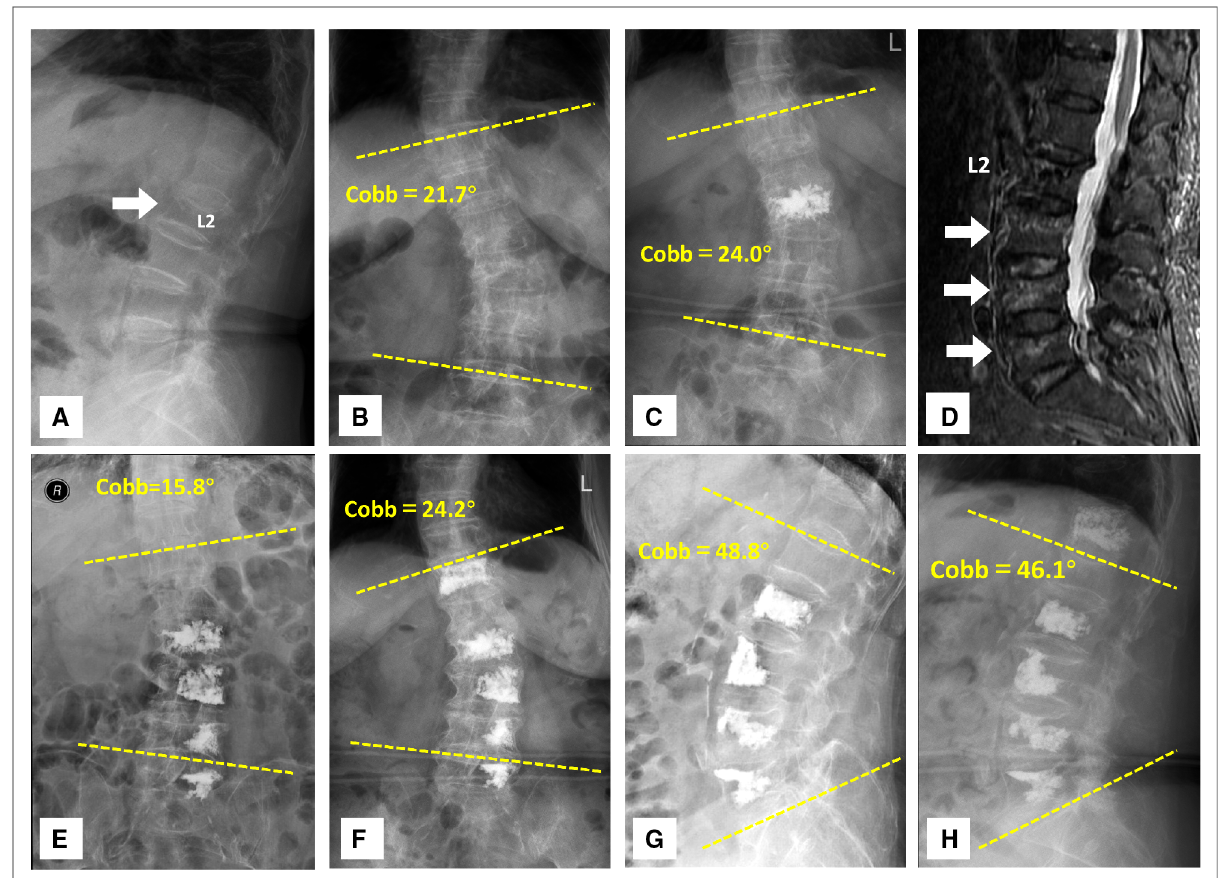
FIGURE 4 An 80-year-old woman presented with a history of osteoporotic vertebral compressive fractures and underwent multiple unilateral PVP. ( A ) The patient had been admitted for management of osteoporosis vertebral compressive fracture at L2 4 years ago. The white arrow indicated the fractured vertebra. ( B ) The preoperative radiograph showed scoliosis with a Cobb angle of 21.7°. ( C ) The patient was treated with PVP for L2 vertebra. The 24-h postoperative anteroposterior x -rays showed the cement augmentation within the L2 vertebra. ( D ) The patient was readmitted for management of progressive osteoporosis vertebral compressive fractures. MRI shows the signal alteration within the fractured vertebrae at L3, L4, and L5. The white arrows indicated the T2-weighted signal abnormalities in the fractured vertebrae. ( E,F ) A progressive Coronal Segmental Cobb angle was observed in the 24-h postoperative and 42-month follow-up anteroposterior x -rays of the thoracolumbar spine. A new T12 vertebral fracture had developed during the long-term follow-up and bilateral PVP were performed for the patient. ( G,H ) The postoperative and follow-up thoracolumbar x -rays demonstrated the mild changes in the sagittal segmental cobb